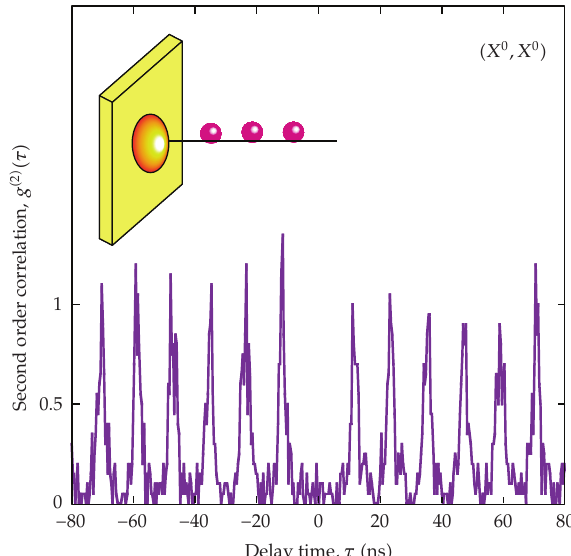
Figure 3: Result of second-order photon correlation measurement under autocorrelation configuration for the X 0 line. The Ti:Sapphire laser with the wavelength of 730nm was used for the excitation. Observed peak separation of ∼ 12.2ns corresponds to an excitation laser frequency of 82MHz. Clear photon antibunching is observed at delay time τ (cid:8) 0, which indicates at most single photon is emitted per single excitation